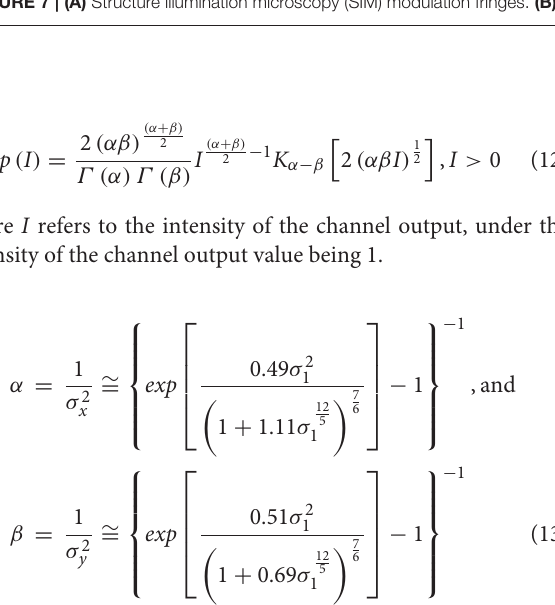
FIGURE 7 | (A) Structure illumination microscopy (SIM) modulation fringes. (B) Modulated object